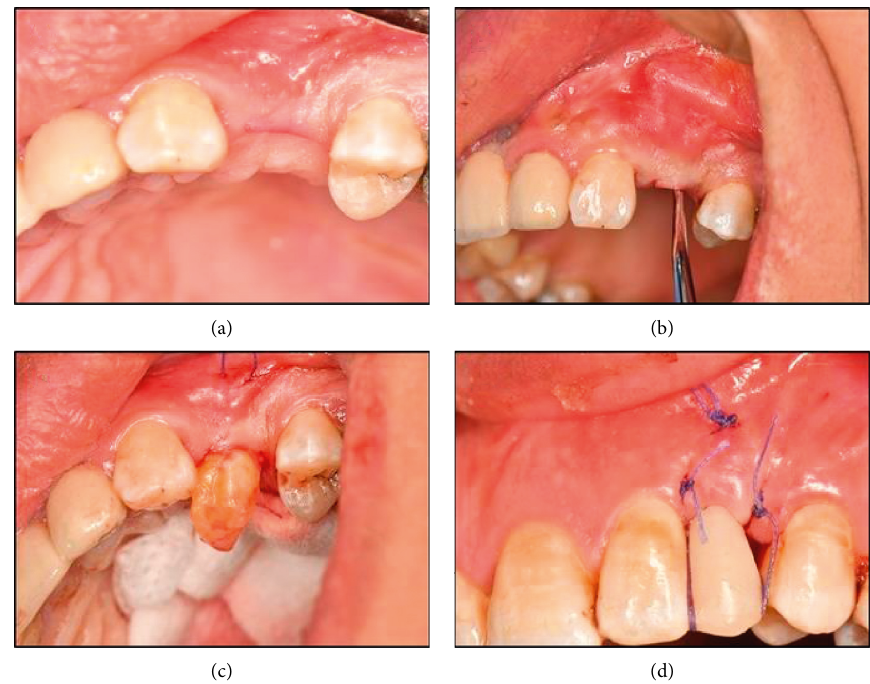
Figure 2: Clinical Photographs showing pouch technique in control group: (a) crestal incision in the site of missing upper left 1 st premolar for pouch preparation, (b) prepared pouch after the extension of the dissection beyond the mucogingival line, (c) pull of the de-epithelialized free gingival graft into the pontic site through the crestal incision in the pouch prepared using positional sutures, (d) Provisional restoration is temporarily cemented and double cross suture are applied, and (e) after six months and final bridge is